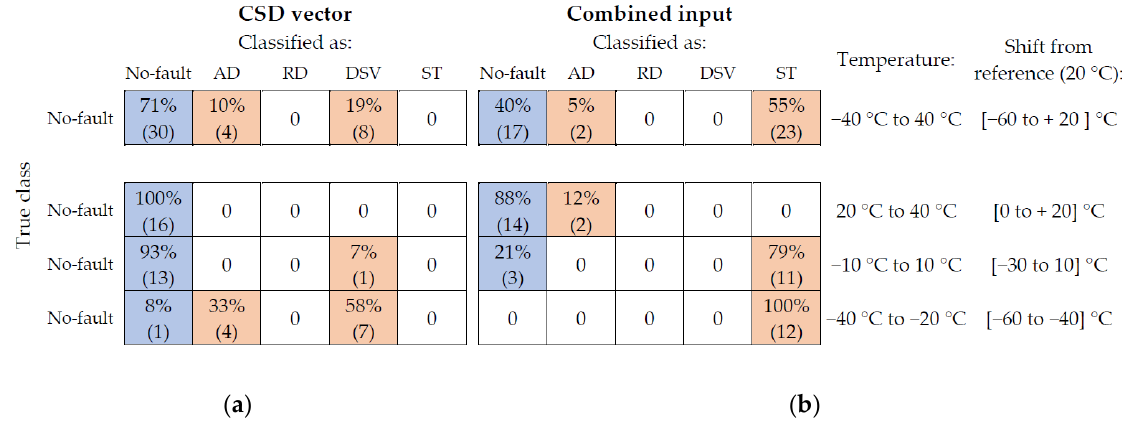
Figure 10. Confusion matrices using temperature database to test the SVM classification algorithm (classification scenario 2) with the following as input: ( a ) CSD vector values and ( b ) combined input with CSD vector and resonances and anti-resonances.